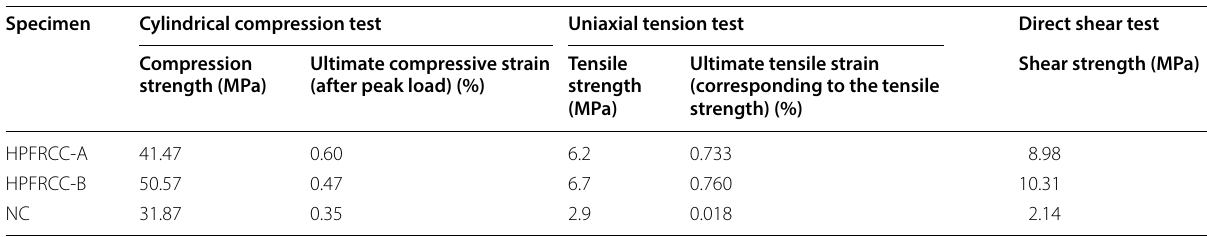
Table 7 Test results for mechanical